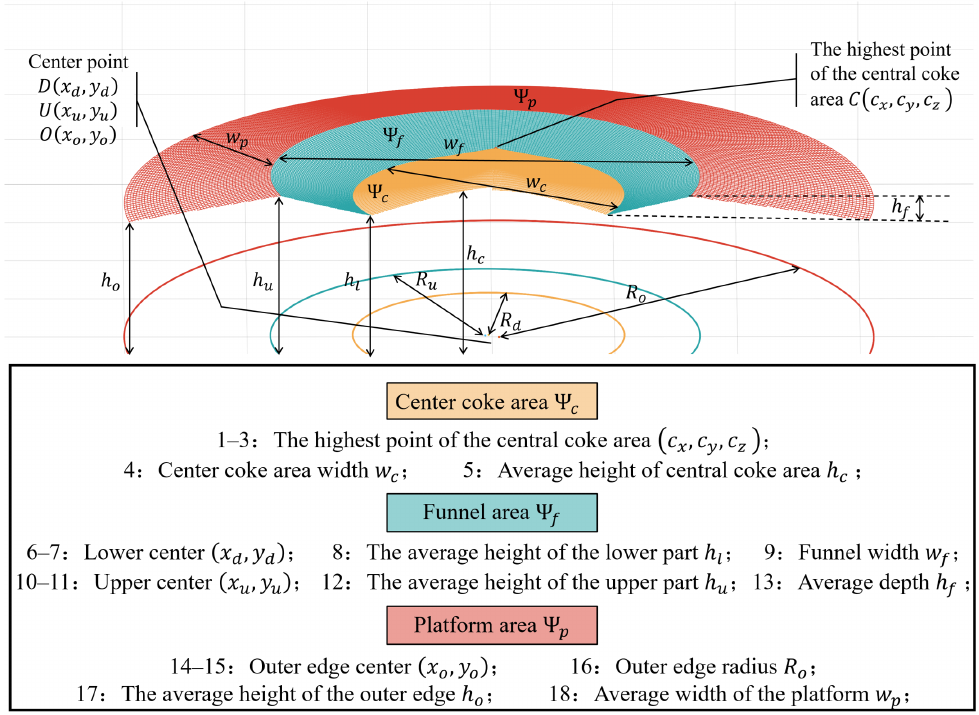
Figure 2. 3D burden surface feature